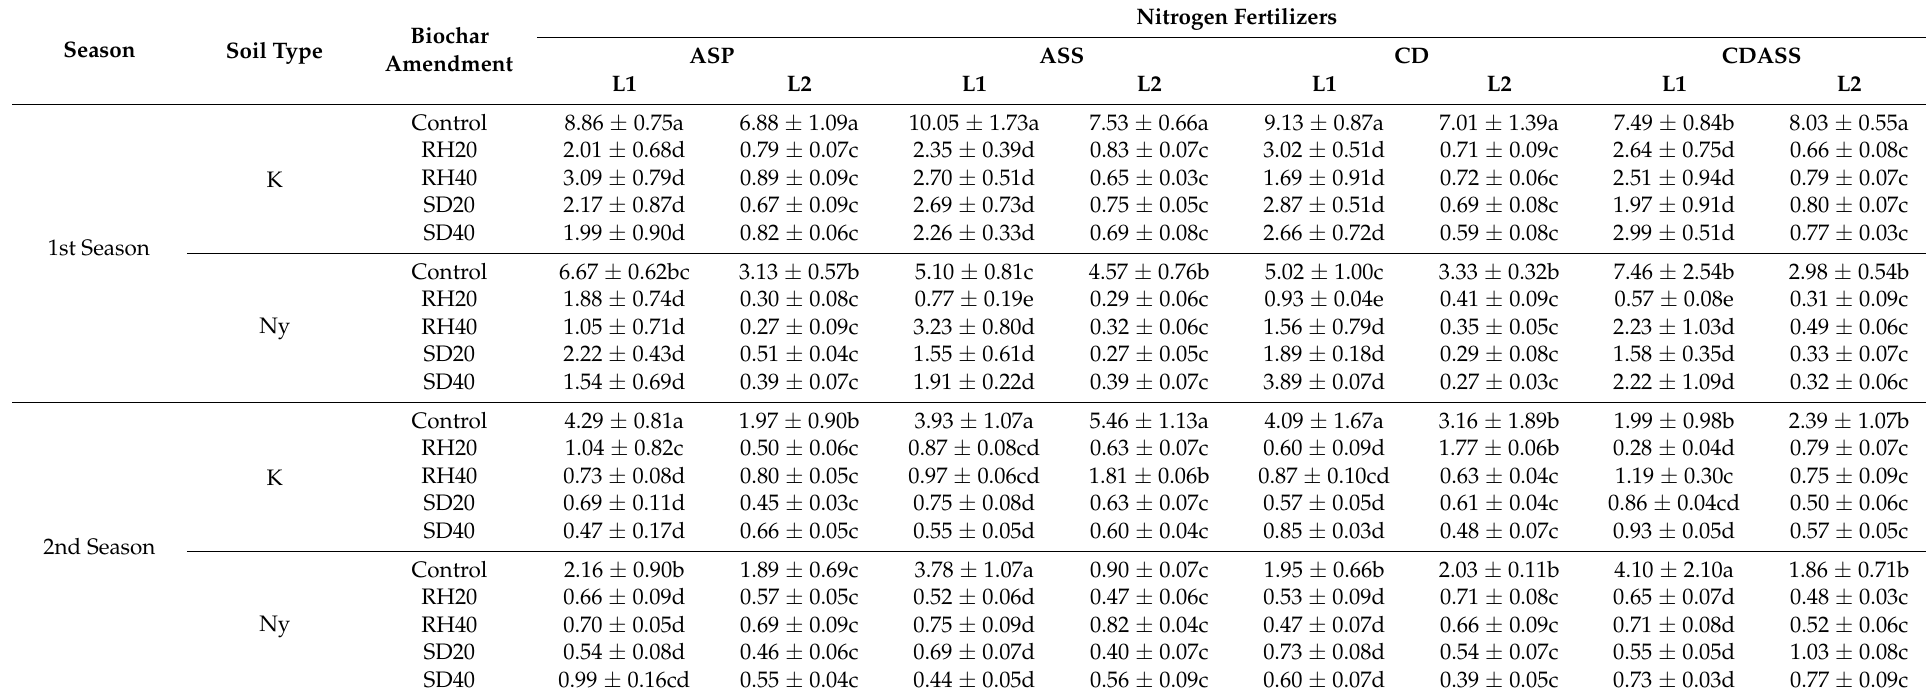
Table 3. Amount of NO 3 − -N leached from the